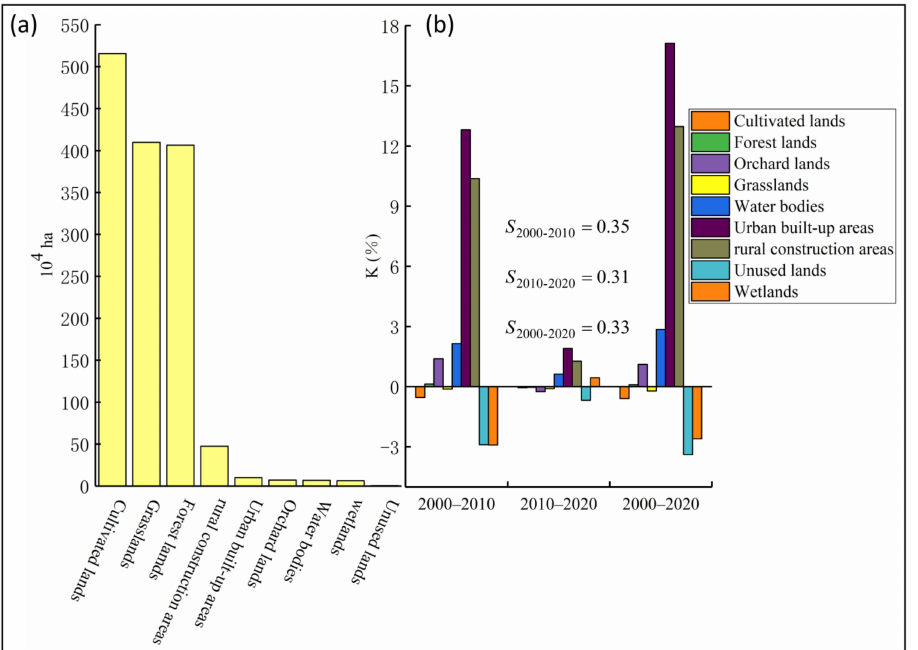
Figure 5. Land use structure ( a ), and dynamic change ( b